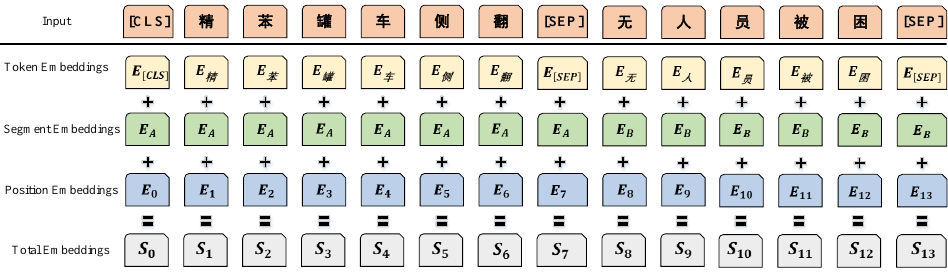
Figure 5. Input representation for the Bert